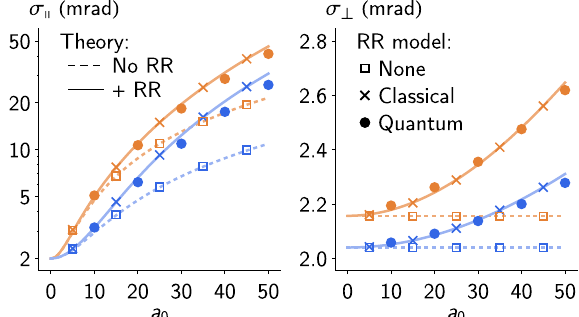
FIG. 1. Parallel and perpendicular standard deviations of the angular profile of the radiation emitted by an electron beam with mean initial energy 500 (orange) and 1000 MeV (blue), as predicted by Eqs. (1) and (2) with (solid curves) and without RR (dashed curves) and from simulations with the specified radiation-reaction model